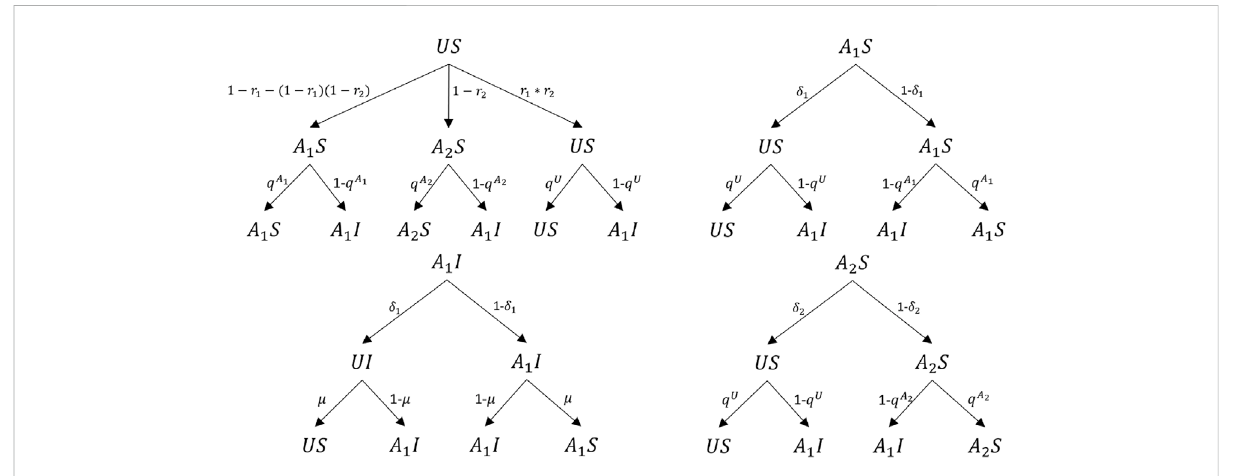
FIGURE 5 Transition probability trees for four states ( US , A 1 S , A 2 S , A 1 I